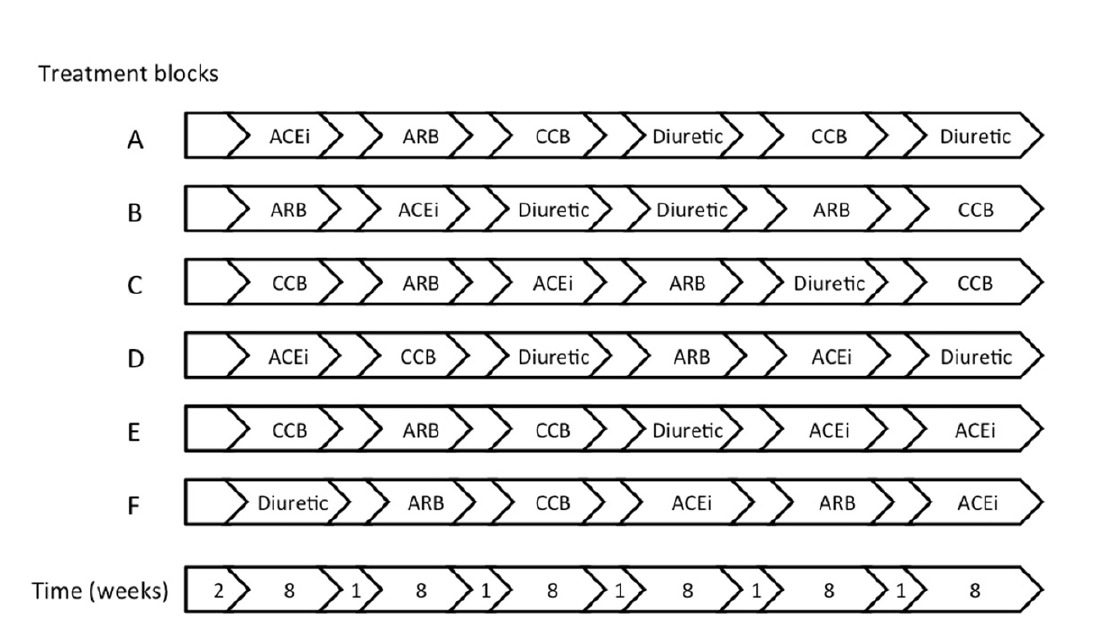
Figure 1. Study design. Each patient is randomly assigned to a treatment sequence created from one of the six possible combinations, by random permutation of the order in which the active treatments are given (the figure is a mere illustration of a few examples of possible sequences). Hence, 1/6 of the patients receive ACEi and ARB in two periods each, 1/6 of patients repeat the ACEi and CCB periods, 1/6 of the patients repeat the ACEi and Diuretic periods, 1/6 repeat the ARB and CCB periods, 1/6 repeat the ARB and Diuretic periods, and 1/6 repeat the CCB and Diuretic periods. Block randomization is used to ensure that approximately the same number of patients are assigned to each of the six combinations of active treatments. ACEi ¼ angiotensin-converting enzyme inhibitor; ARB ¼ angiotensin receptor blocker; CCB ¼ calcium channel blocker; Diuretic ¼ thiazide diuretic. Blank arrows indicate placebo run-in and wash-out.